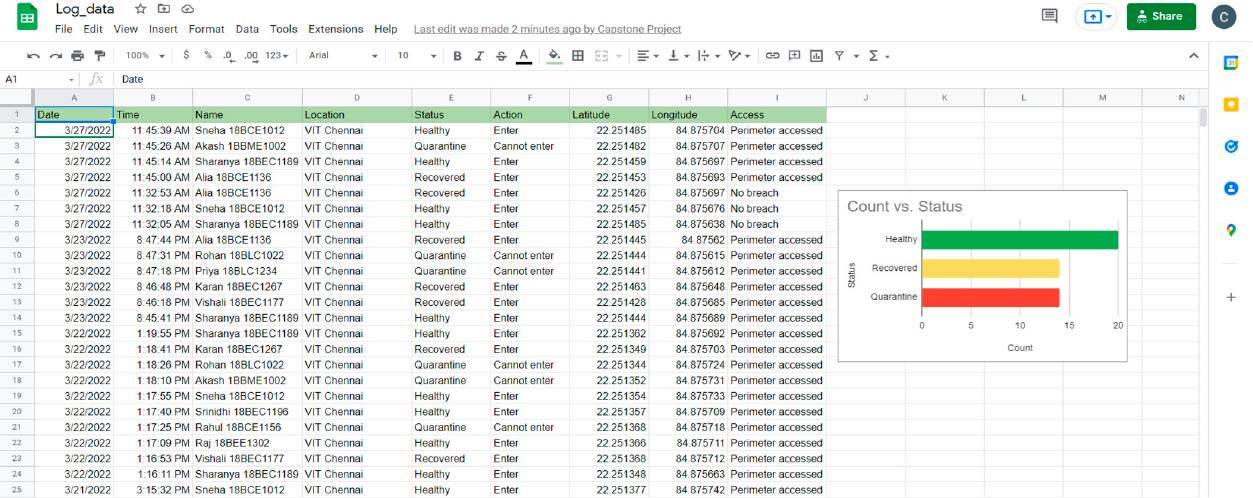
Figure A4. Log data page with live user information.